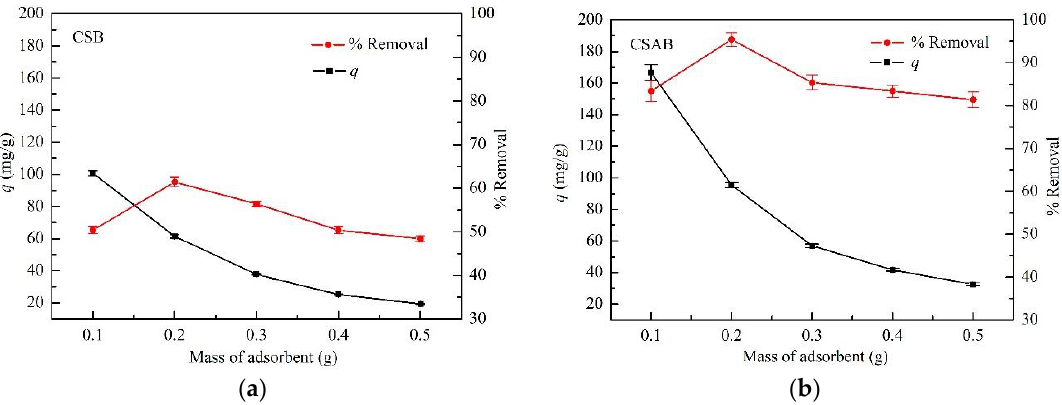
Figure 5. Effect of sorbent dosage on the adsorption of diesel oil onto: ( a ) CSB; ( b ) CSAB.